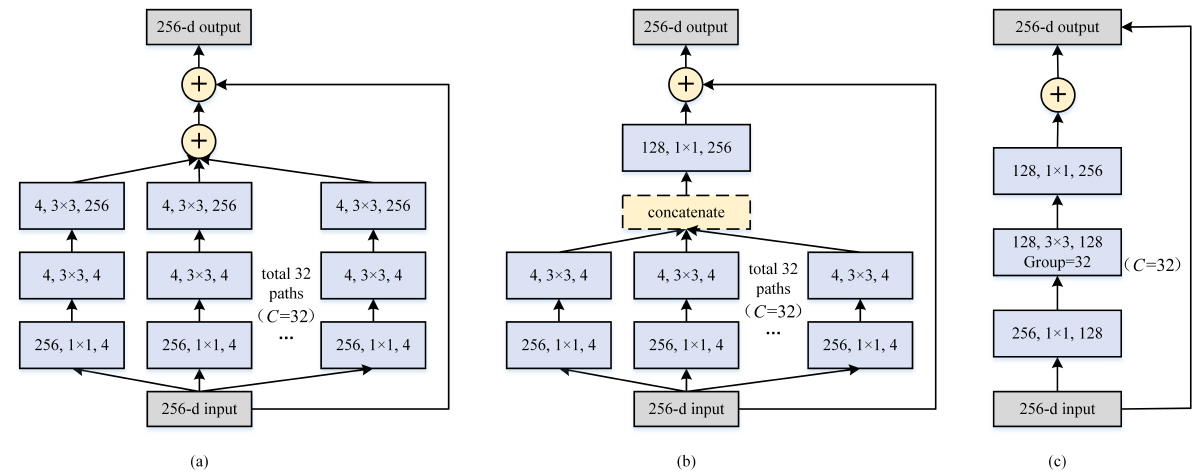
Figure 18. ( a – c ) Equivalent building blocks of